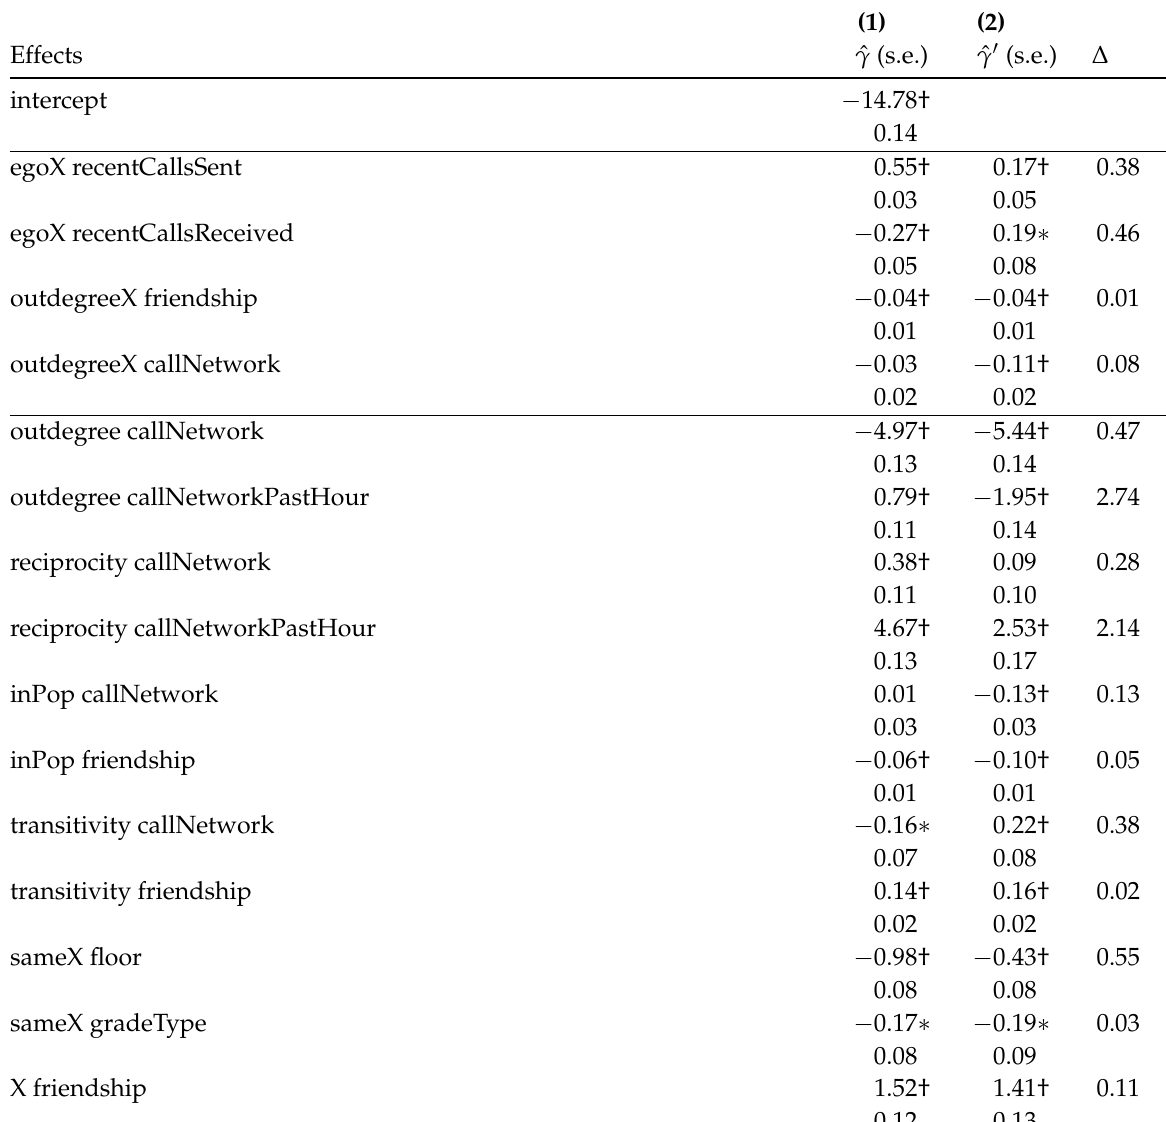
Table 3: Comparison of the bias of the REM induced by ignoring right-censored intervals.